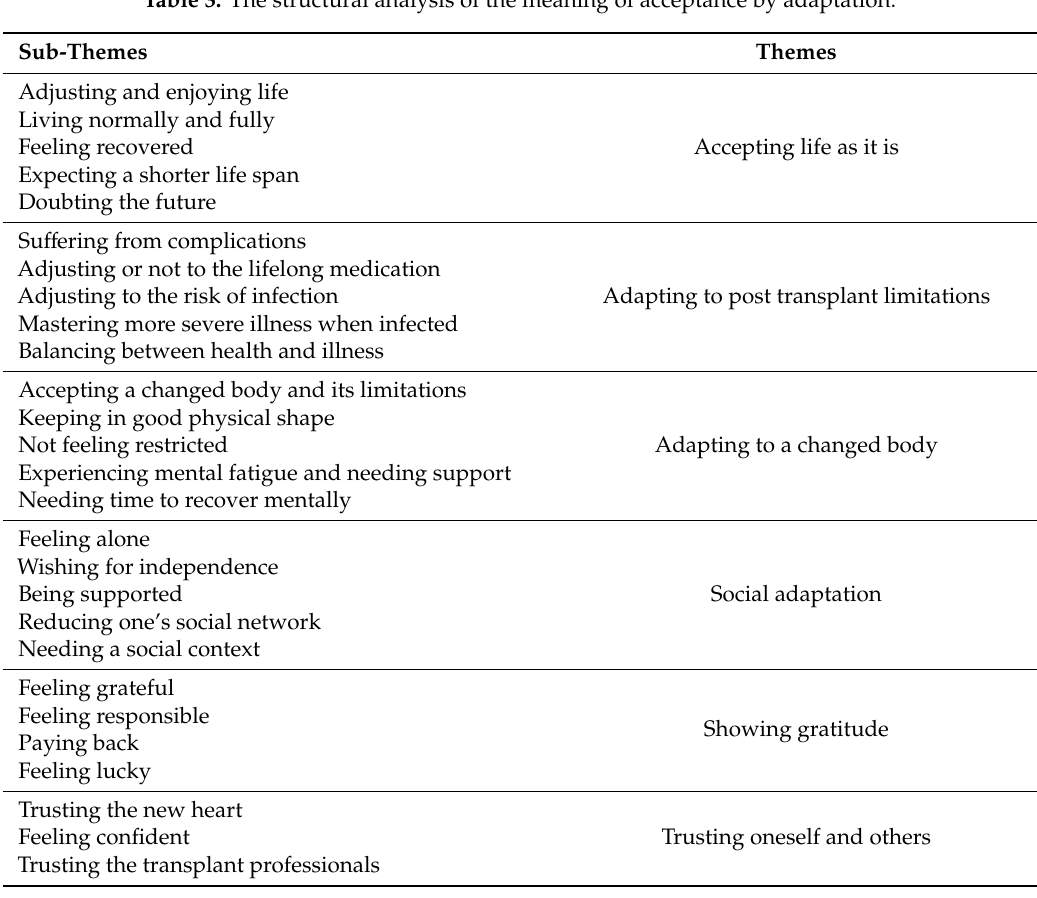
Table 3. The structural analysis of the meaning of acceptance by